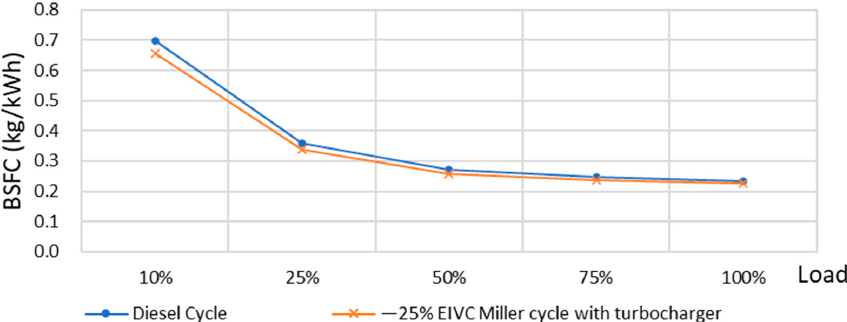
Figure 13. Comparison of BSFC between diesel engine and EIVC Miller cycle turbocharger diesel engine.